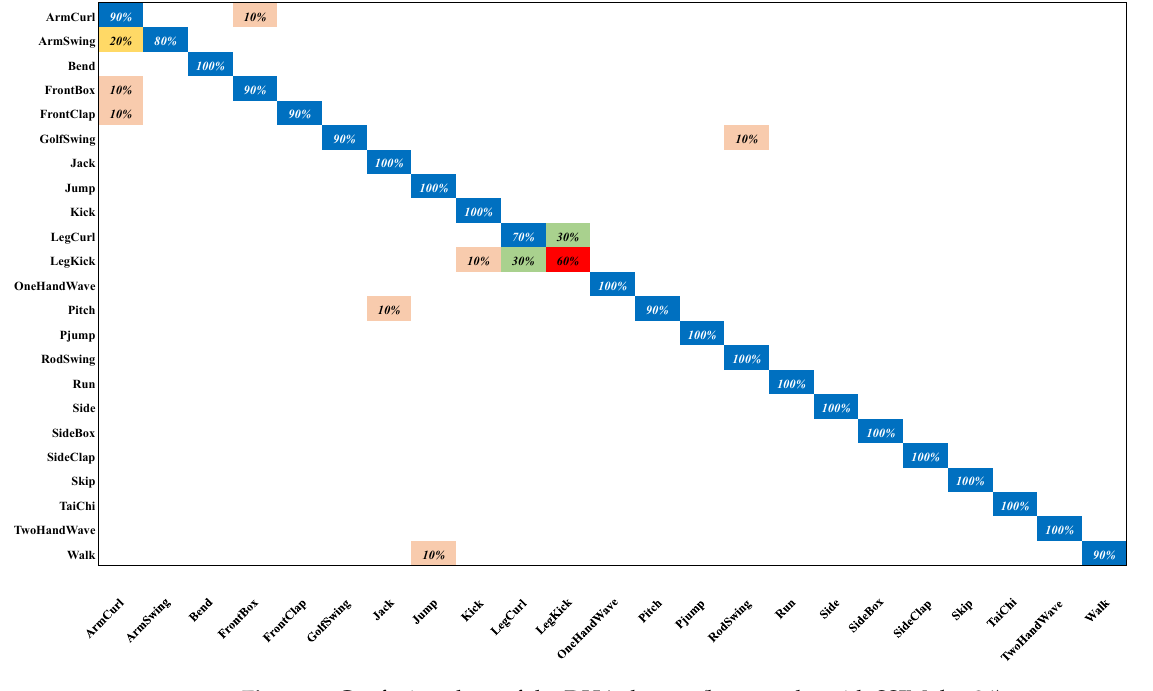
Figure 8. Confusion chart of the DHA dataset (best results with SSIM, k = 24).